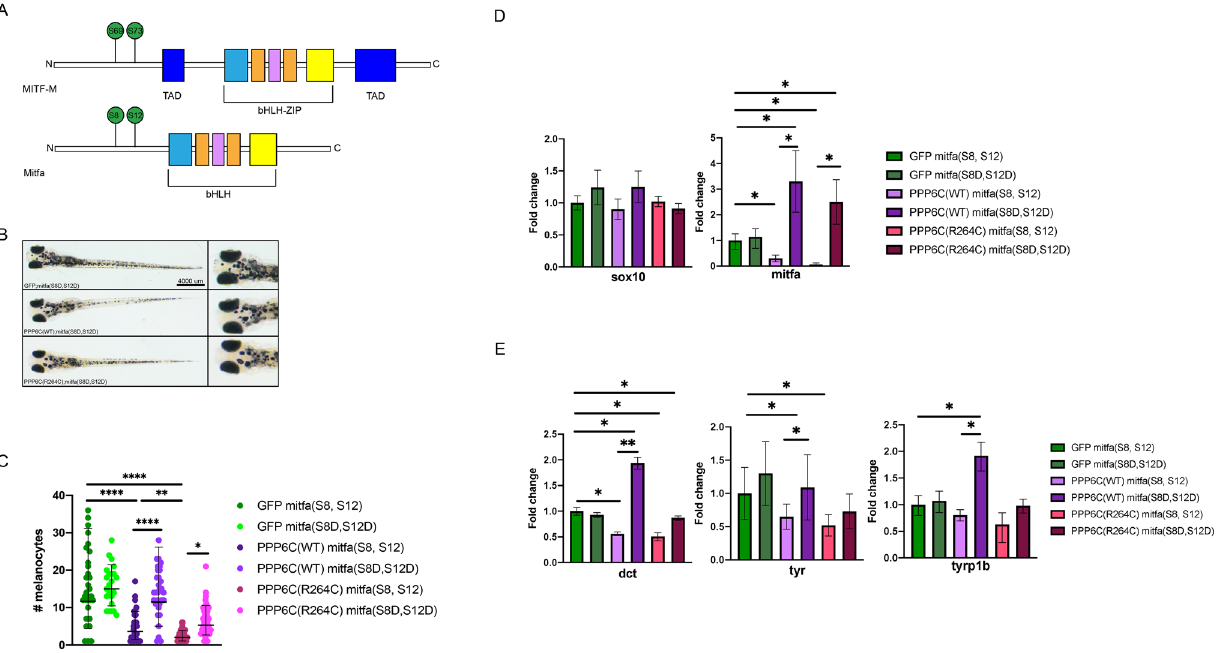
Figure 3. MITF mutation prevents PPP6C-mediated melanocyte differentiation disruption . ( A ) Schematic of the human MITF-M and zebrafish Mitfa proteins. ( B ) Representative images of 5 day old fish on the roy;nacre background injected with either MC-GFP;mitfa(S8D,S12D), MC-PPP6C;mitfa(S8D,S12D), or MC-PPP6C(R264C ) ;mitfa(S8D,S12D). ( C ) Representative counts of melanocytes of 5 day old fish on the roy;nacre background injected with either MC-GFP, MC-PPP6C, or MC-PPP6C(R264C) and with either MITF(S8,S12) or the MITF(S8D, S12D) mutations (Student’s two-tailed t-test). ( D ) Real-time qPCR measurement of SOX10 and MITF in 48 h post fertilization fish injected with either MC-GFP, MC-PPP6C or MC-PPP6C(R264C) and with either MITF(S8,S12) or the MITF(S8D, S12D) mutations (Student’s two-tailed t-test). ( E ) Real-time qPCR measurement of DCT, TYR, and TYRP1B in 48 h post fertilization fish injected with either MC-GFP, MC-PPP6C or MC-PPP6C(R264C) with and with either MITF(S8,S12) or the MITF(S8D, S12D) mutations. All data panels in the figure are representative of at least three experiments. p -values are indicated as following: * p < 0.05, ** p ≤ 0.01, **** p ≤ 0.0001.